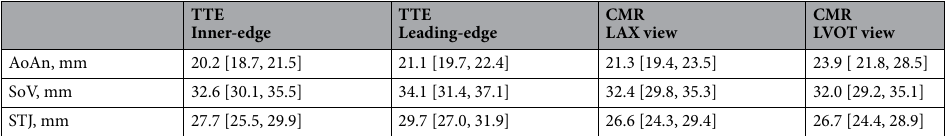
Table 2. Aortic root measured by transthoracic echocardiography and cardiac magnetic resonance imaging (CMR). Continuous variables are presented as median and IQR. AoAn aortic annulus, CMR cardiac magnetic resonance imaging, LAX long axis, LL leading-edge method, LVOT left ventricular outflow tract, SoV sinus of Valsalva, STJ sinotubular junction, TTE transthoracic echocardiography.